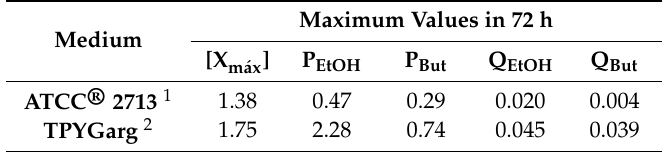
Table 7. Cell concentration ([X 24 ] (g d.w. cells / L)), ethanol and butanol production (P EtOH and P But , respectively, in g / L) and productivities (Q EtOH and Q But , respectively, in g / L • h) after 72 h of syngas fermentation by Clostridium carboxidivorans .